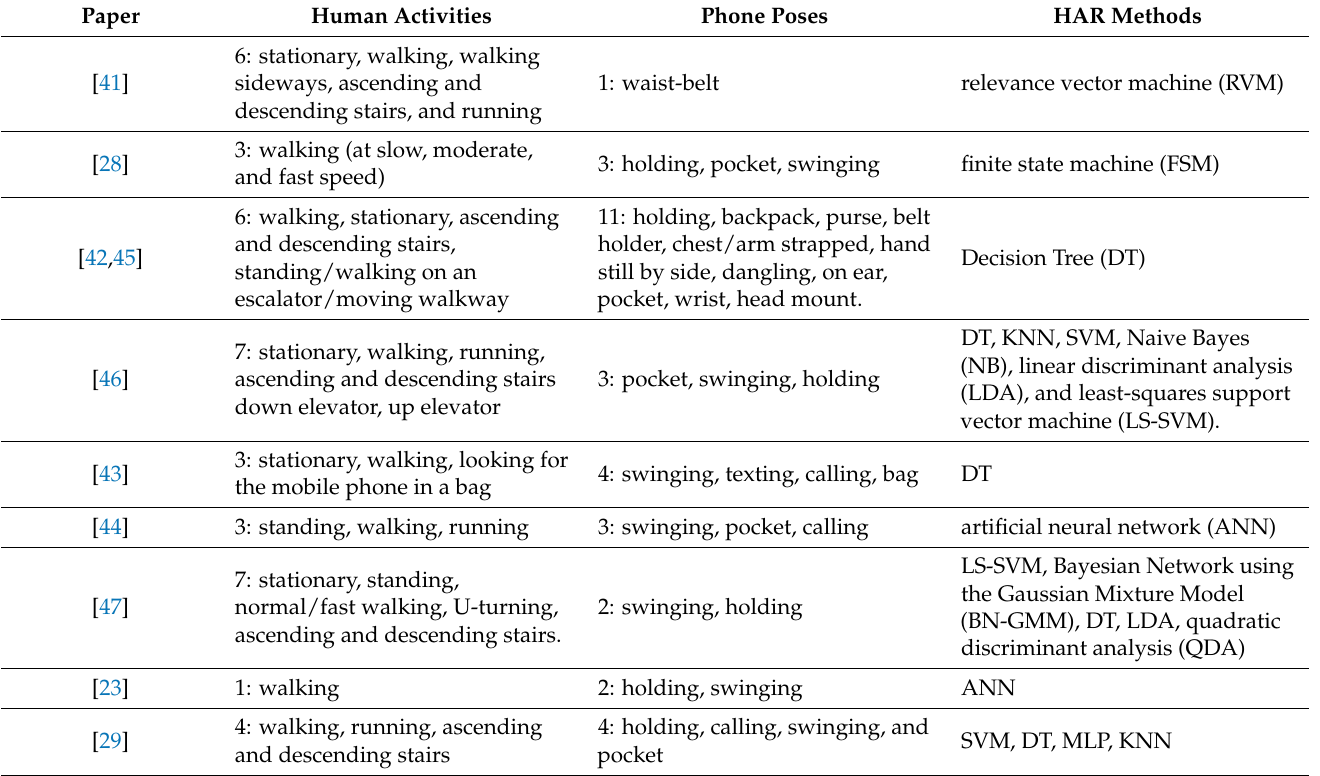
Table 1. Human activities, phone poses, and HAR methods ( walking means in a relatively straight line).